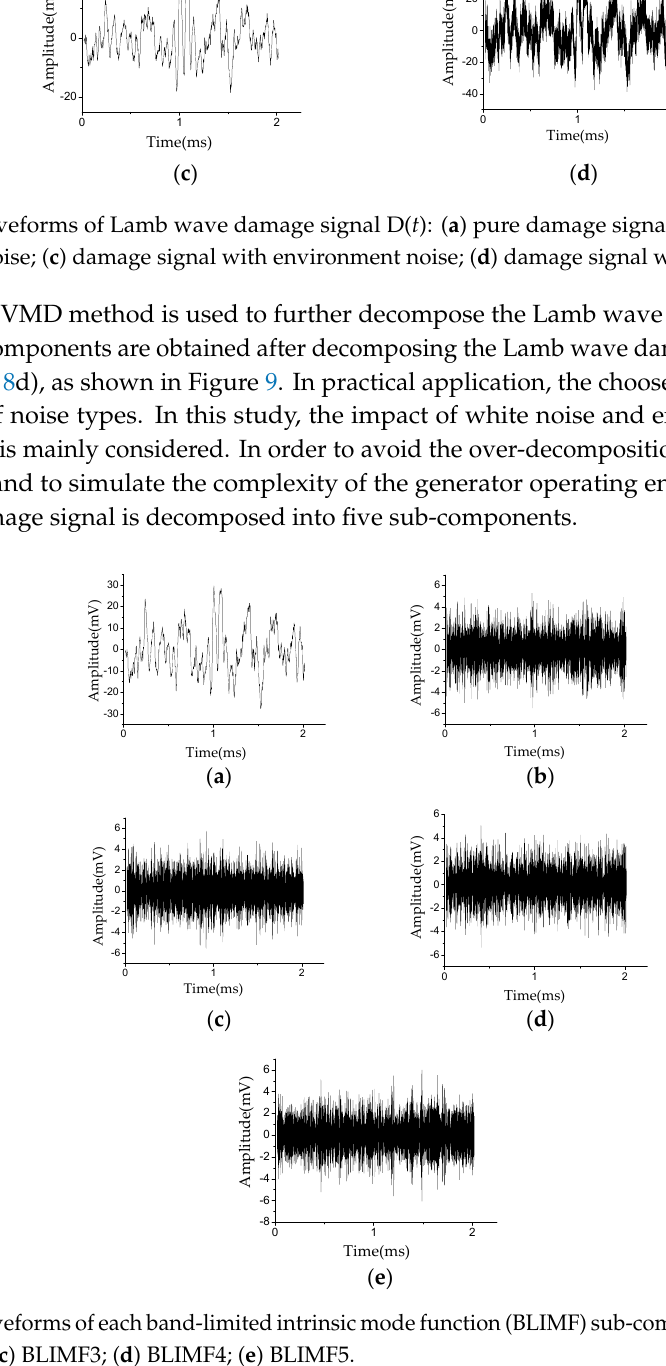
Figure 9. Waveforms of each band-limited intrinsic mode function (BLIMF) sub-component: ( a ) BLIMF1; ( b ) BLIMF2; ( c ) BLIMF3; ( d ) BLIMF4; ( e ) BLIMF5. ( b ) BLIMF2; ( c ) BLIMF3; ( d ) BLIMF4; ( e )